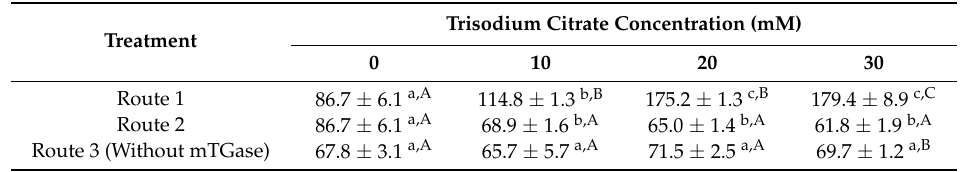
Table 2. The effects of trisodium citrate on the firmness (mN) of casein gels 1 .